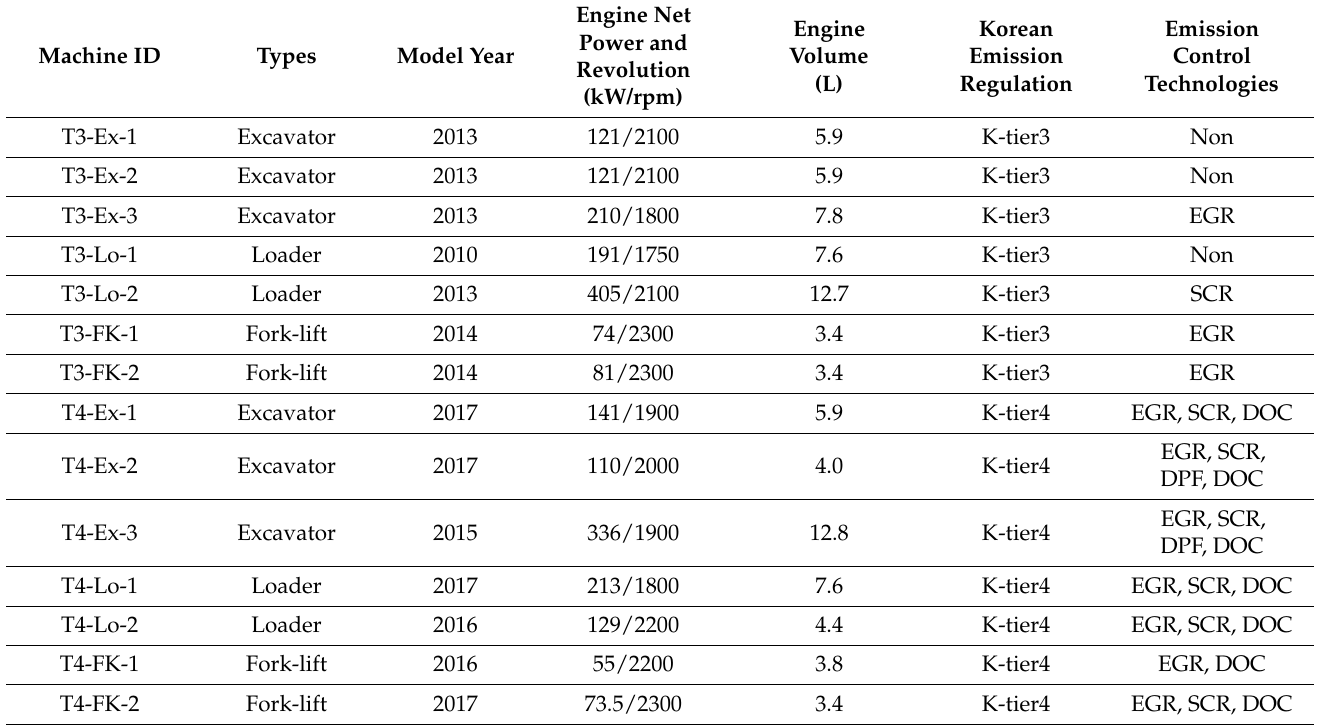
Table 1. Main specifications of the construction machinery being